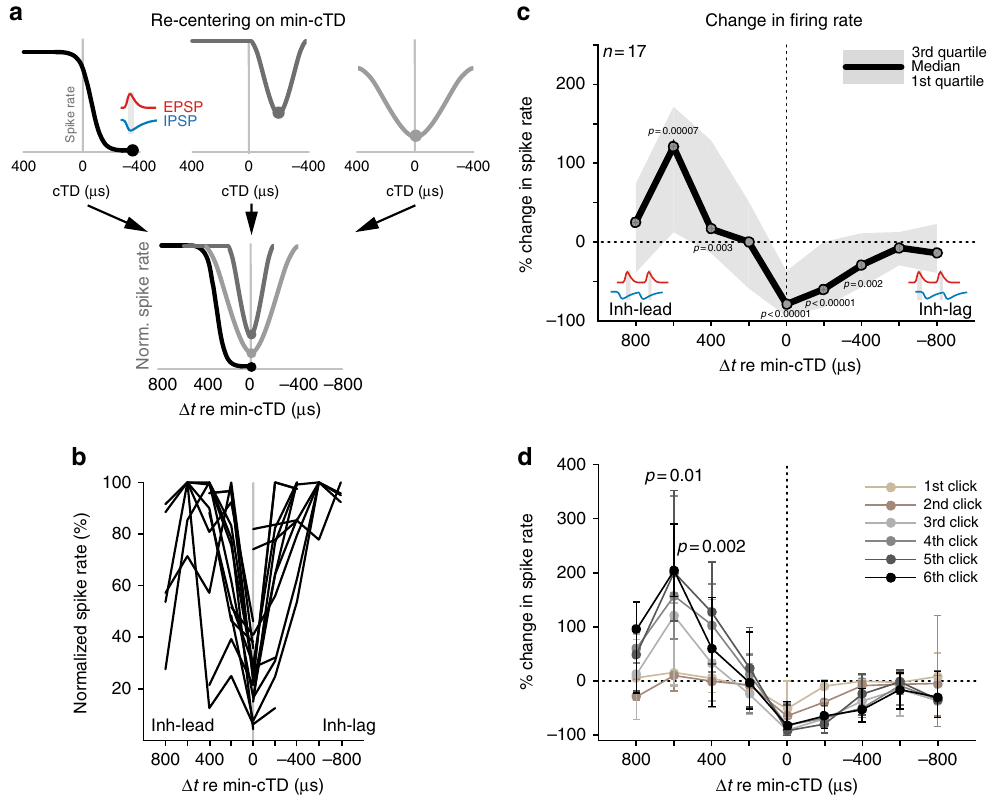
Fig. 3 Precisely timed, preceding inhibition underlies spike facilitation in vivo. a Schematic of the re-positioning of cTD-spike rate functions: functions were re-centered on each neurons ’ min-cTD (illustrated by fi lled circles, only three schematic functions are shown here), resulting in an extended Δ t -axis ( – 800 to 800 µ s). This way, all cTD-response functions were normalized to the cTD of coincidence between excitation and inhibition (inset in top left panel). b Normalized Δ t -spike rate functions at best ICI of each neuron ( n = 17) after re-centering. c Median changes in spike rate relative to their respective response rate during Exc. only stimulation for the re-centered Δ t -spike rate functions of all cells tested ( n = 17). Next to the expected decrease of spike rates near Δ t = 0, an increases in relative spike rate is apparent for Δ t values of 600 µ s (120.6%, P = 0.00007, paired Wilcoxon signed rank test) and 400 µ s (16.3%, p 0.003, paired Wilcoxon signed rank test). Shaded area denotes interquartile ranges. d A similar dependency of response facilitation on Δ t is apparent on the level of changes in fi ring rates to individual clicks (color-coded). Notably, facilitation increased with clicks later in the train ( P = 0.01 and P = 0.002 at Δ t = 600 µ s and Δ t = 400 µ s, respectively, Friedman ’ s test). Data points are mean ±